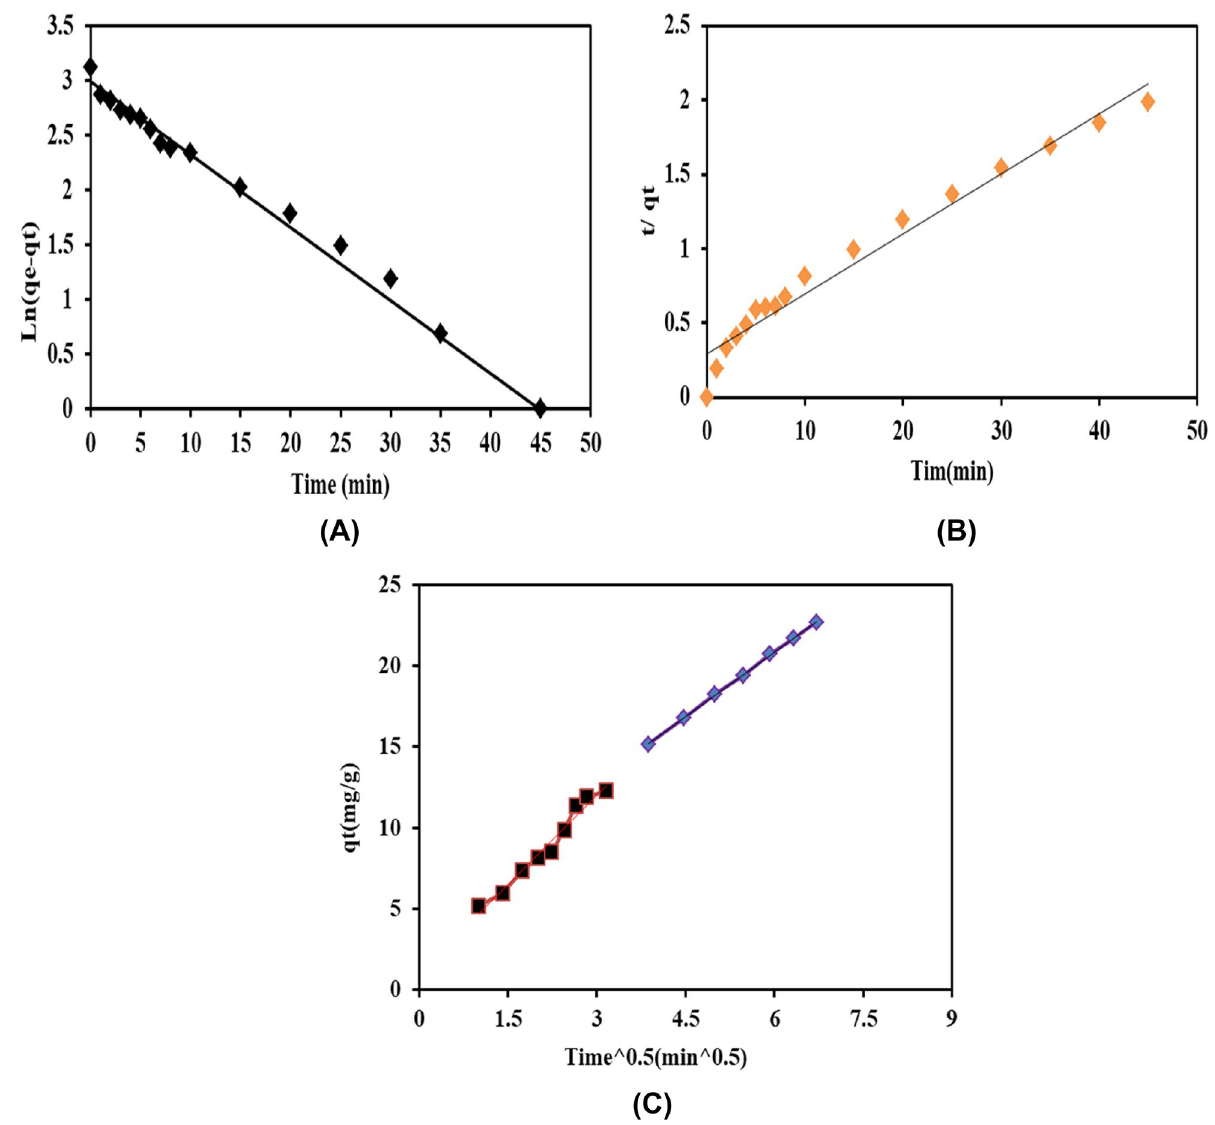
Figure 9. Adsorption kinetics of CR dye onto K@AM-CTS composite beads; ( A ) the pseudo-first order kinetic model, ( B ) the pseudo-second order kinetic and ( C ) Intra-particles diffusion model.